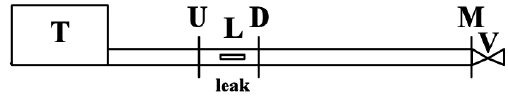
Figure 2. Sketch of the experimental setup (T = supply tank, U = section upstream of the leak, L = leak device, D = section down- stream of the leak, M = section immediately upstream of the ma- noeuvre valve, V = manoeuvre valve).